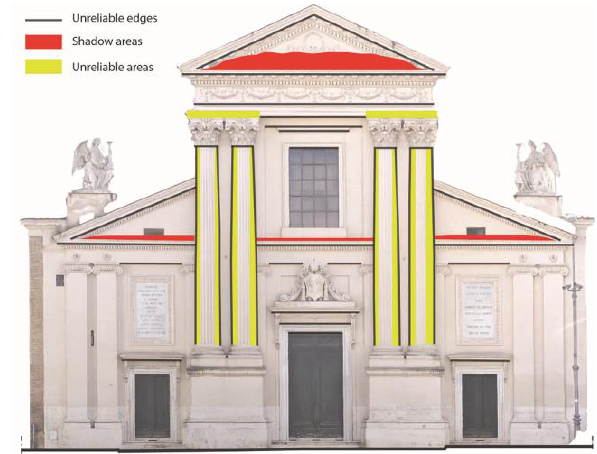
Figure 9. Map of unreliable areas in the ortho-photo